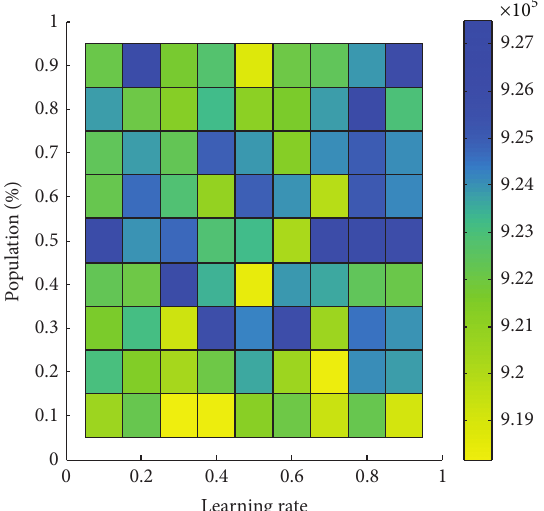
Figure 9: Performance of EDA /Φ 2 at various values of its parame-